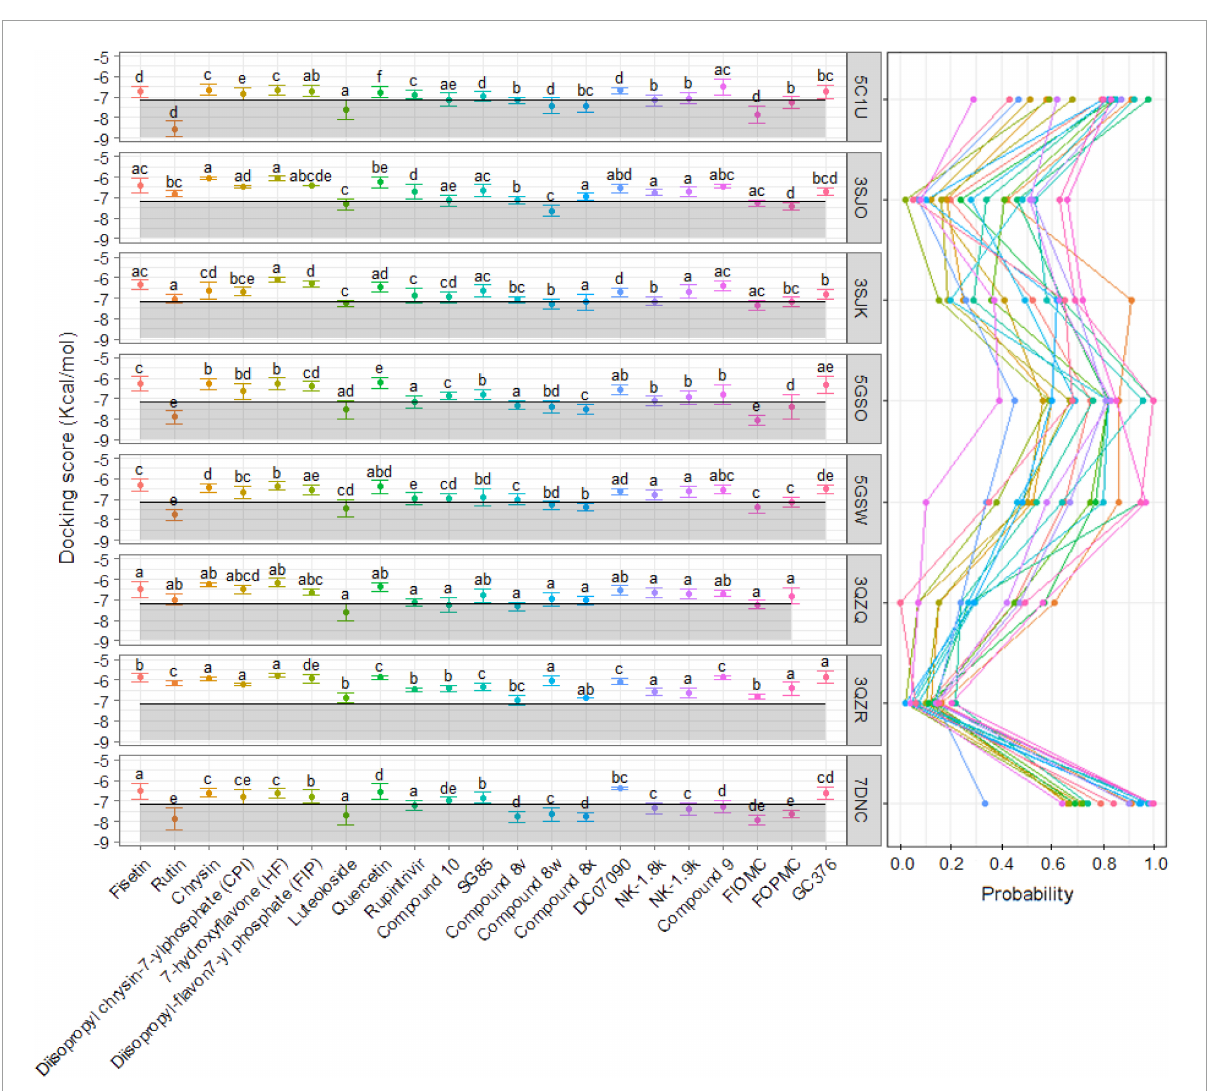
FIGURE5 The average with standard deviation of docking scores (left) and the probability of models (right) at cluster 1—the active site—in each of 21 ligands and eight selected proteins. The shaded area was drawn based on the average docking score of all modal ligands at the active site with the 5C1U as a control. The significant difference was calculated by Kruskal–Wallis test and presented by different alphabets ( α = 0.05) between each of eight proteins interacted with same